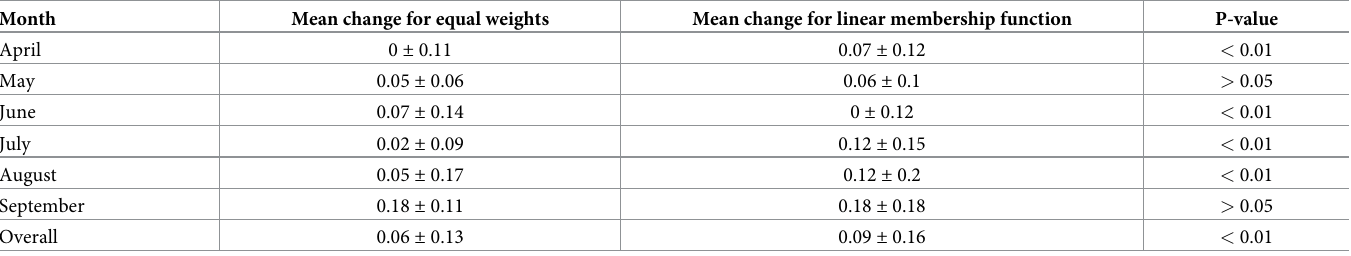
Table 9. Sensitivity analysis results. Mean change in values (n = 96) between original multicriteria decision analysis outputs compared to new maps with either equal weights for all predictor variables, or assuming linear membership functions for all predictor variables.